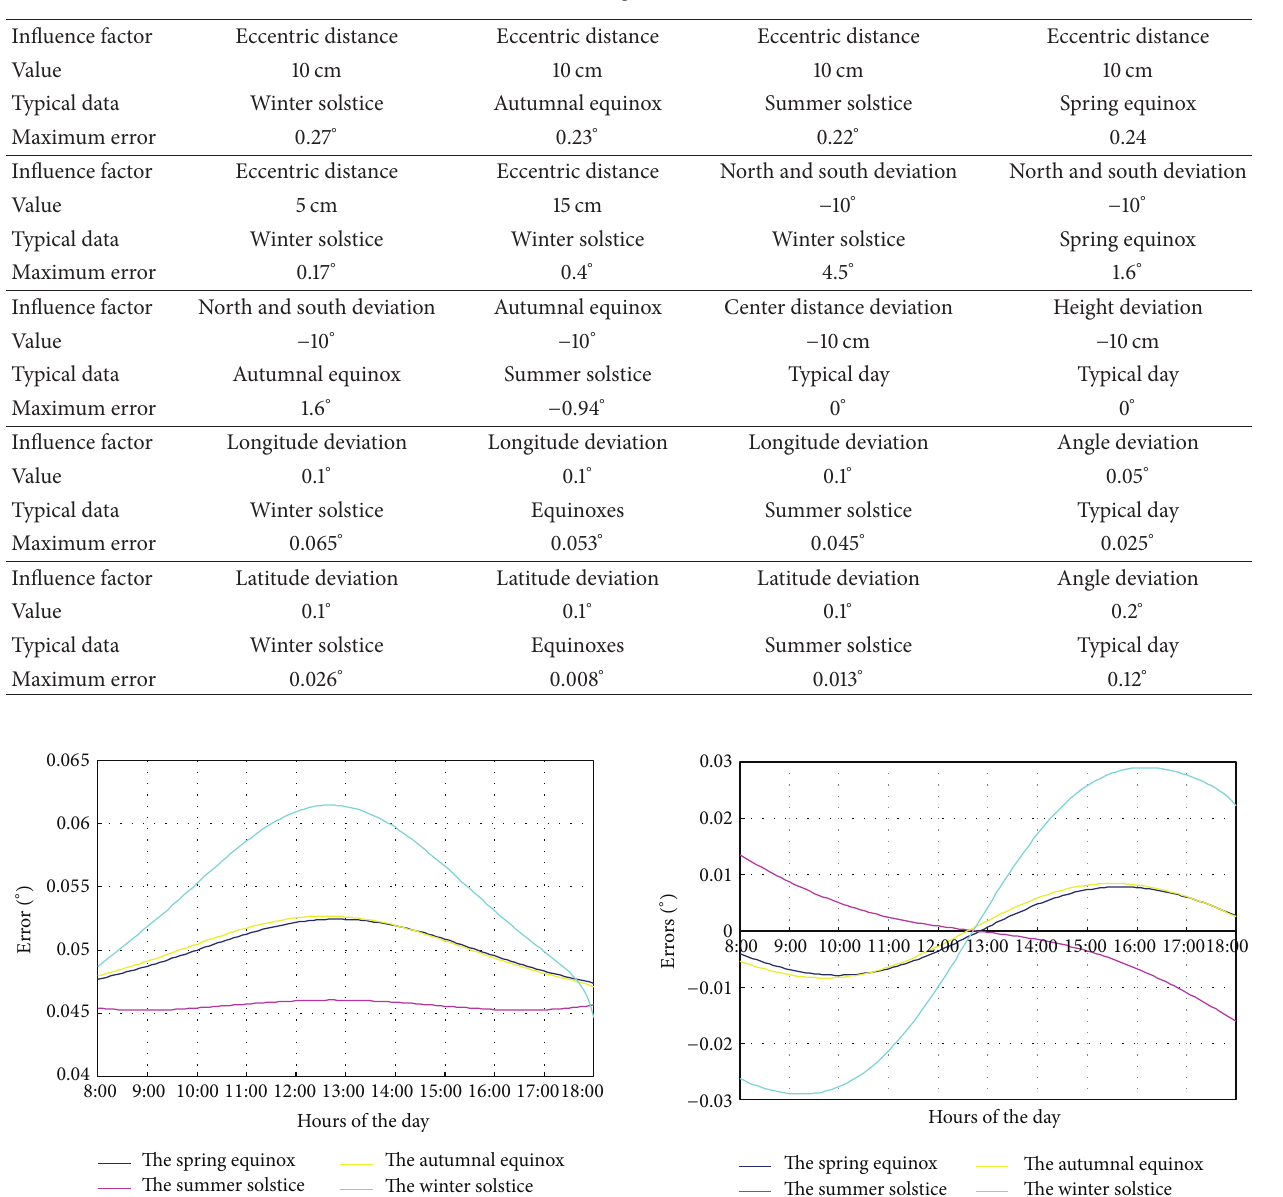
Table 1: Effect of the tracing error for the middle mirror.